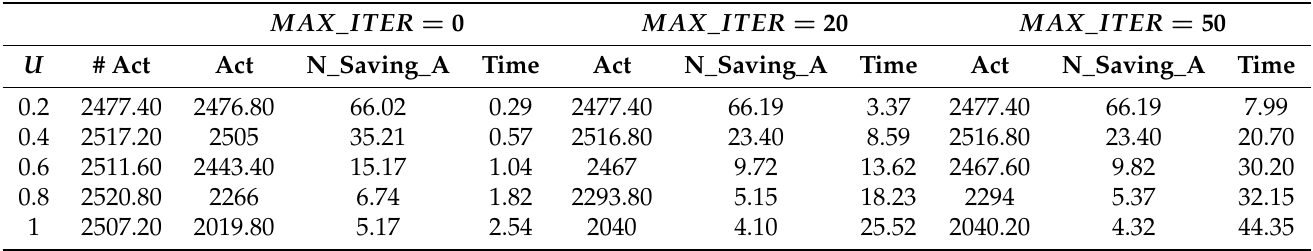
Table 8. 12eight servers-1000 flows-Activation scheduling—Phase 2 Simple.